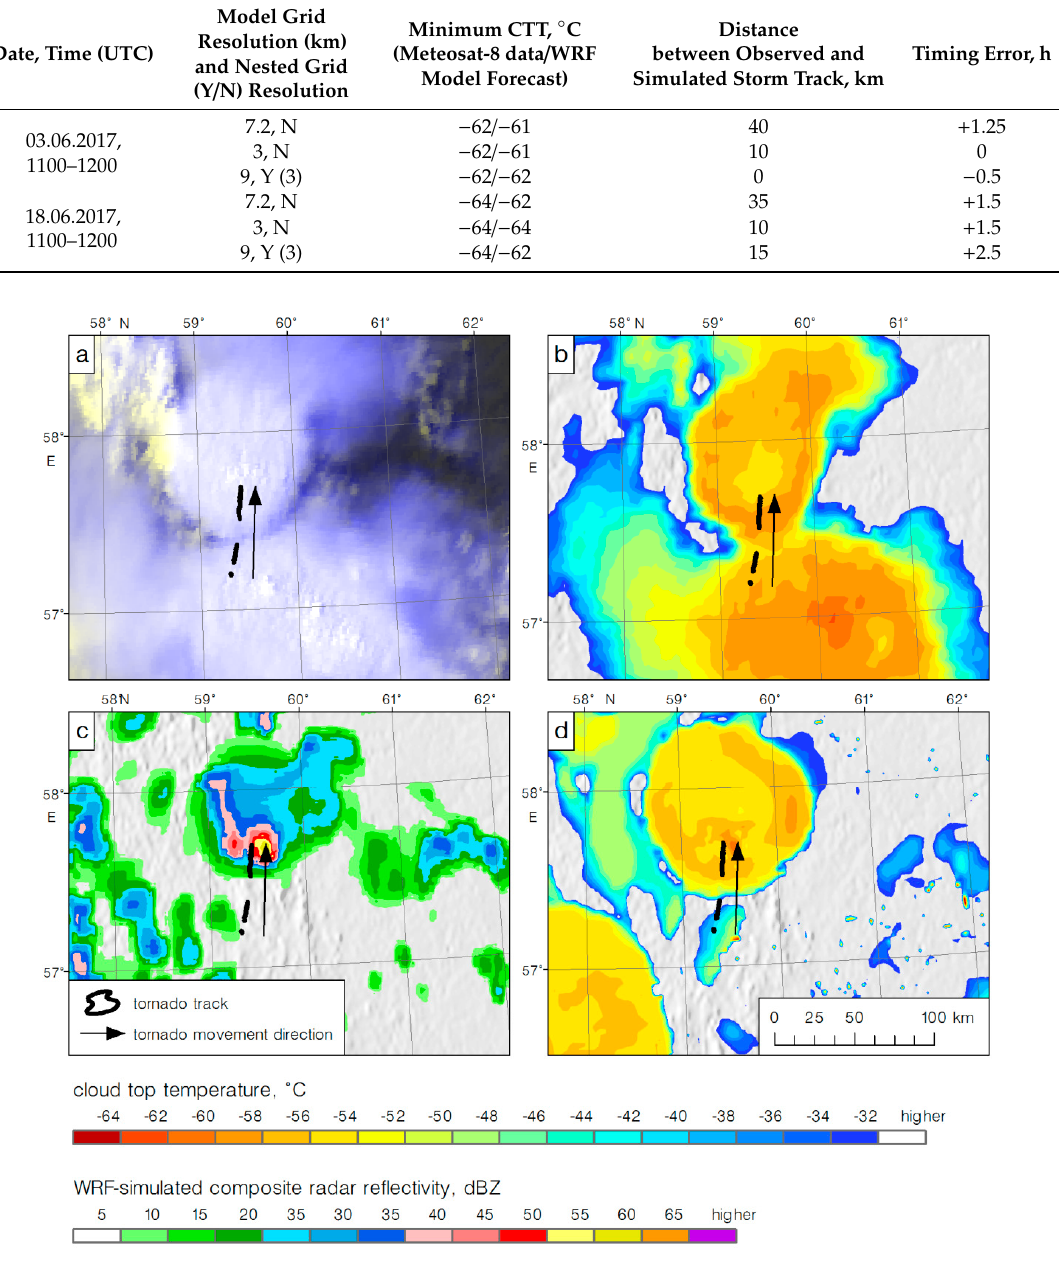
Figure 11. HRV cloud RGB image ( a ) and cloud top temperature ( b ) by the Meteosat-8 data; WRF-simulated composite reflectivity ( c ) and cloud top temperature ( d ) at 1200 UTC 3 June 2017 (the WRF configuration with a 3-km resolution with no nested grid).